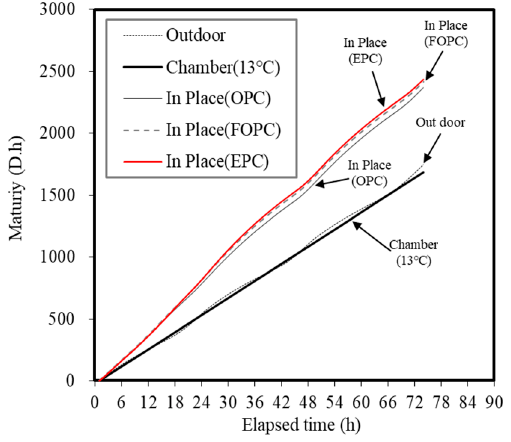
Figure 8. Concrete maturity trends for concrete when using different curing methods.